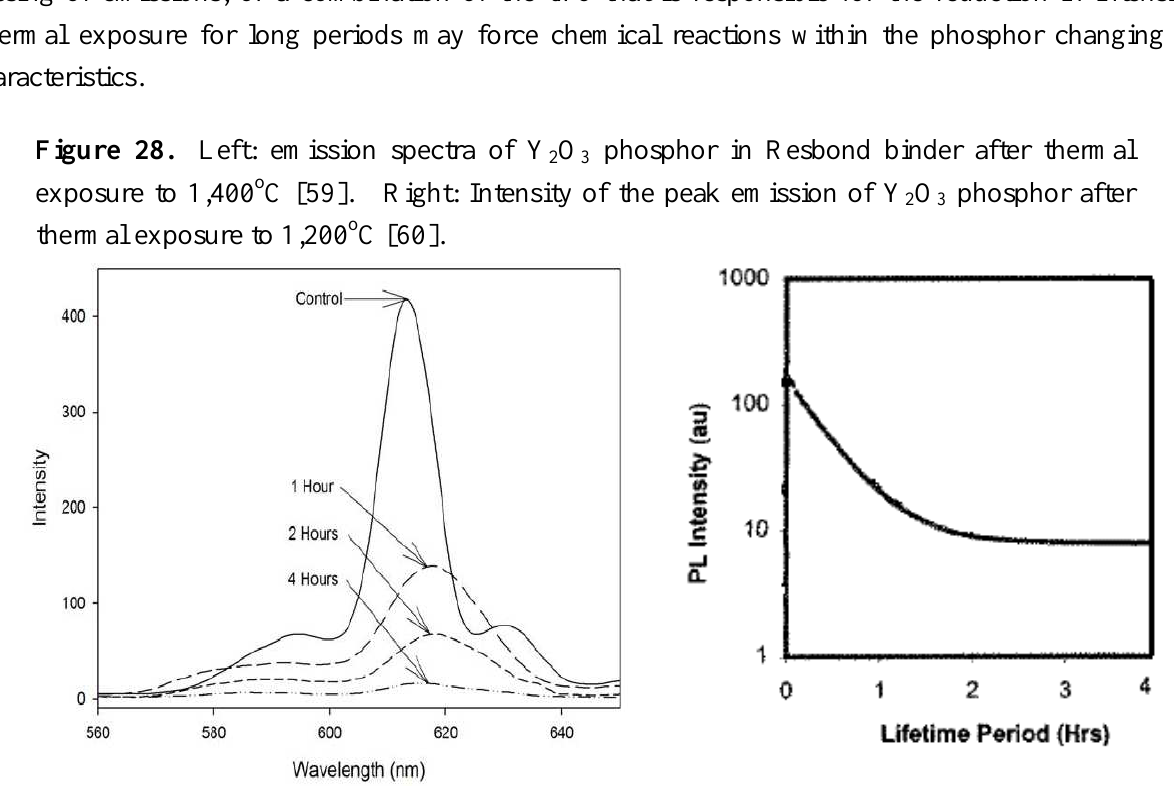
O phosphor in Resbond binder after thermal 2 3